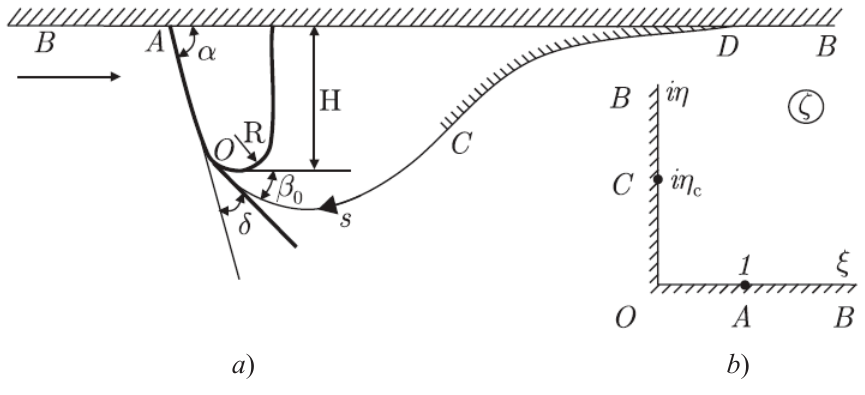
Figure 1. Flow sketch: ( a ) physical plane ( b ) parameter, or ζ